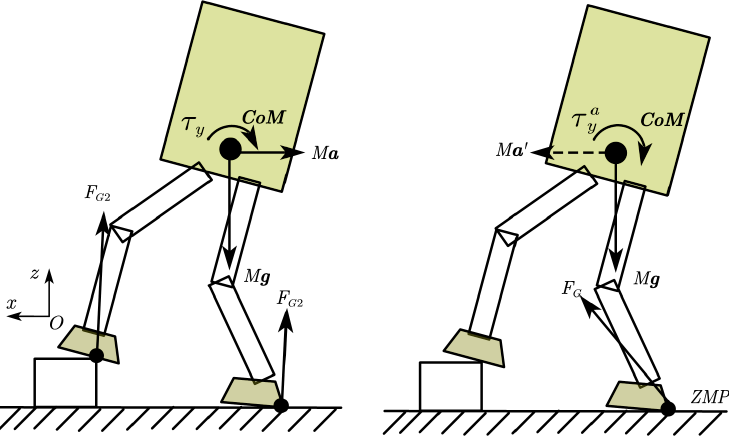
Figure 3. Linear momentum compensation strategy. The left side is the original situation, and the robot has a larger trend of accelerating backward. On the right is the case of generating instantaneous clockwise rotation, which reduces the trend of accelerating backward.